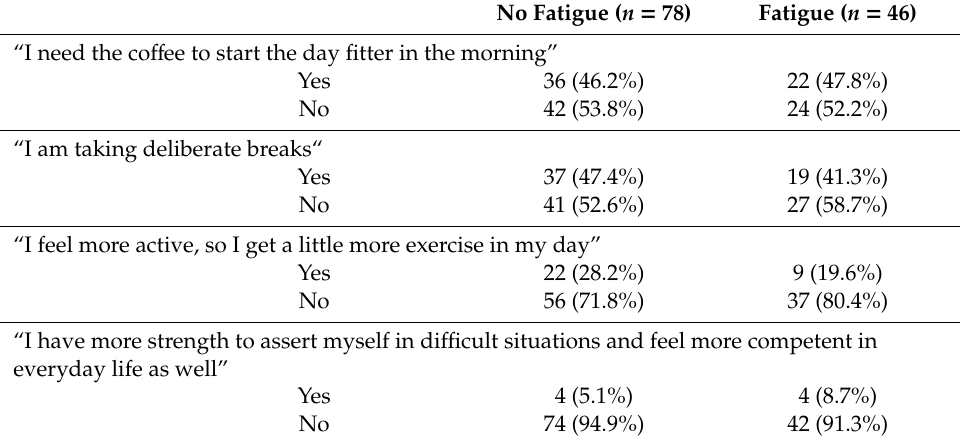
Table 3. E ff ects of co ff ee consumption of MS patients without and with fatigue. No Fatigue ( n = 78) Fatigue ( n =